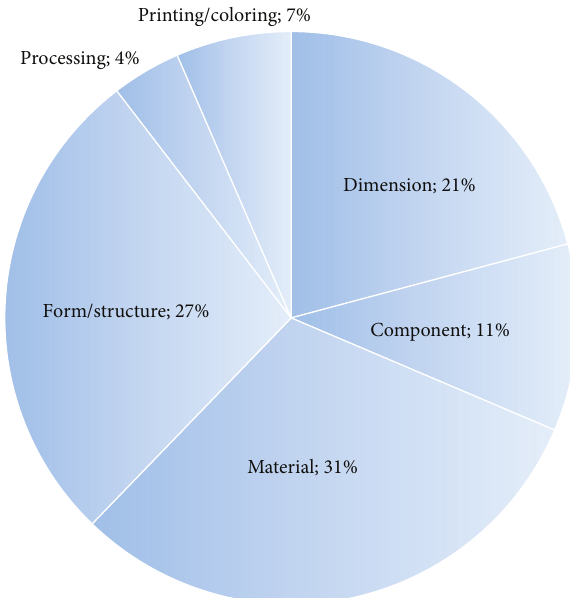
Figure 1: Six idea categories of second-look VE cases for home